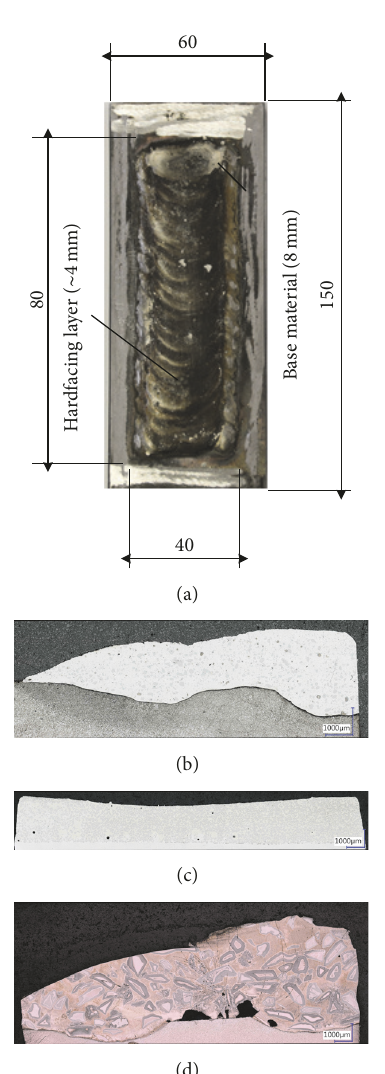
Figure 1: Specimen geometry and difference of the added WC: (b) small distribution with FW (No. 3), (c) fine distribution with PTA (No. 5), and (d) coarse distribution with interspersing technology (No. 7).